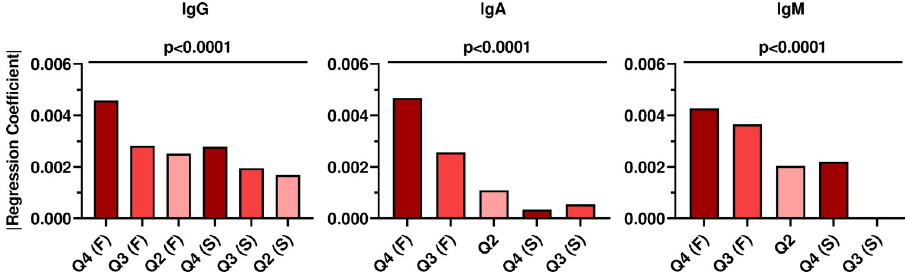
Fig 5. Comparison of RBD + antibody decay between quartile groups for each isotype in COVID-19 recovered patients. Linear regression models were fitted to each quartile for all the isotypes. The linear regression coefficients were determined from the F and S phases of the two-phase decay model. Y-axis shows the absolute regression coefficient, x-axis represents the quartile and the phase of the decay (F/S and no indication for F/S if the regression did not fir a two-phase decay model) For all plots, p values, R 2 , effective degrees of freedom(edf), and slopes are shown in S2 Table. p values < 0.05 were considered significant.